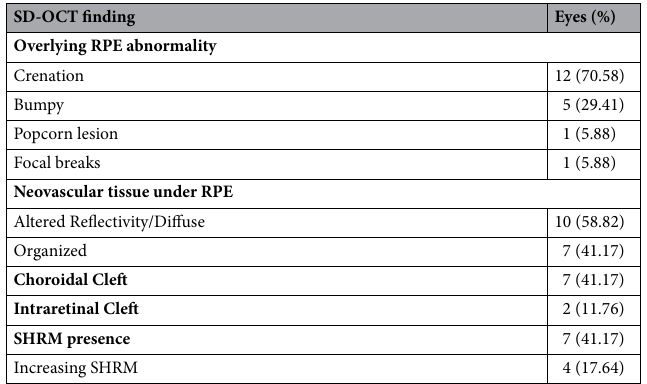
Table 3. Spectral domain optical coherence tomography findings in MLPED. MLPED: multilayered pigment epithelial detachment; SD-OCT: Spectral Domain Optical Coherence Tomography; RPE: Retinal pigment epithelium; Crenated RPE seen as undulated Microfolds of RPE; Popcorn lesion refers to focal reflective lesion at the RPE simulating herniation of neovascular tissue breaching RLE, Focal breaks seen as punctate defects in the RPE; SHRM: Subretinal hyperreflective material.